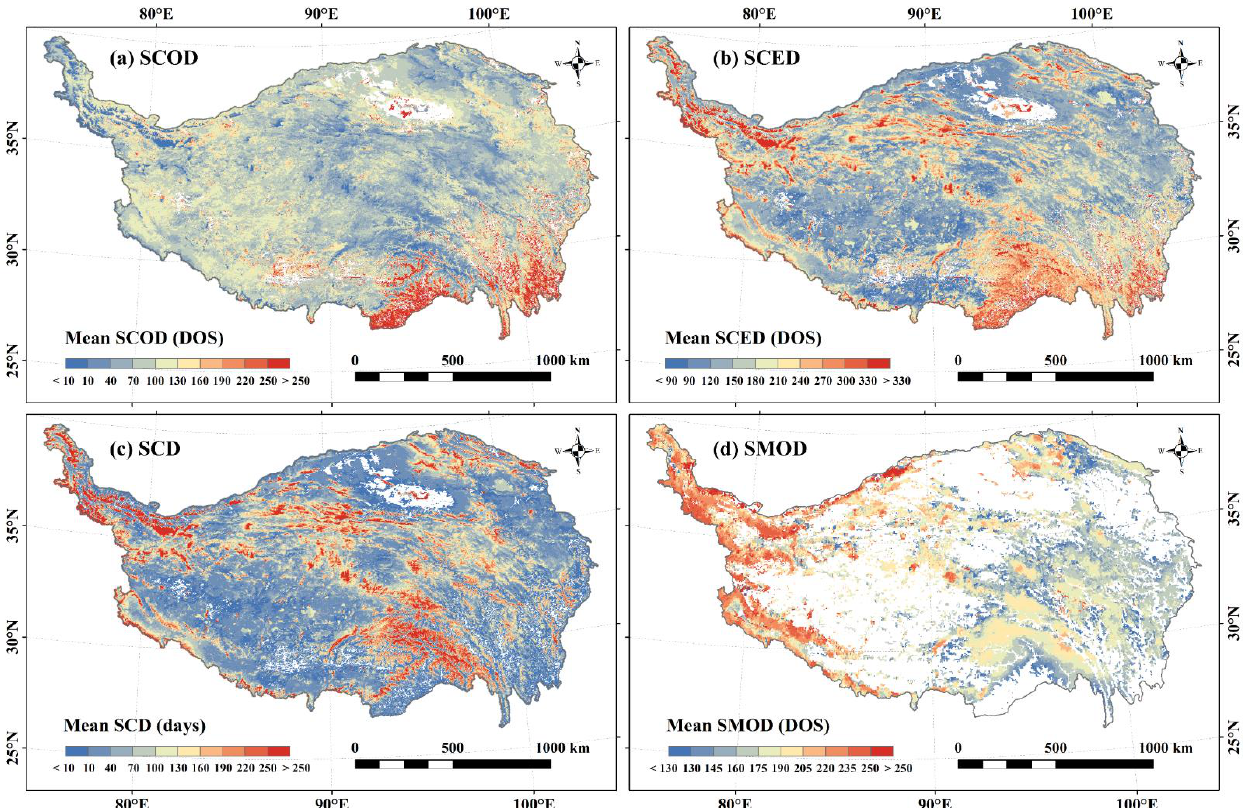
Figure 4. The spatial variation in the annual mean snow cover phenology metrics, i.e., ( a ) SCOD, ( b ) SCED, ( c ) SCD, and ( d ) SMOD, during 2003 – 2020. Note that DOS represents the day of snow cover season. Thus, DOS 1 is equivalent to DOY 274 (October 1) of last year.